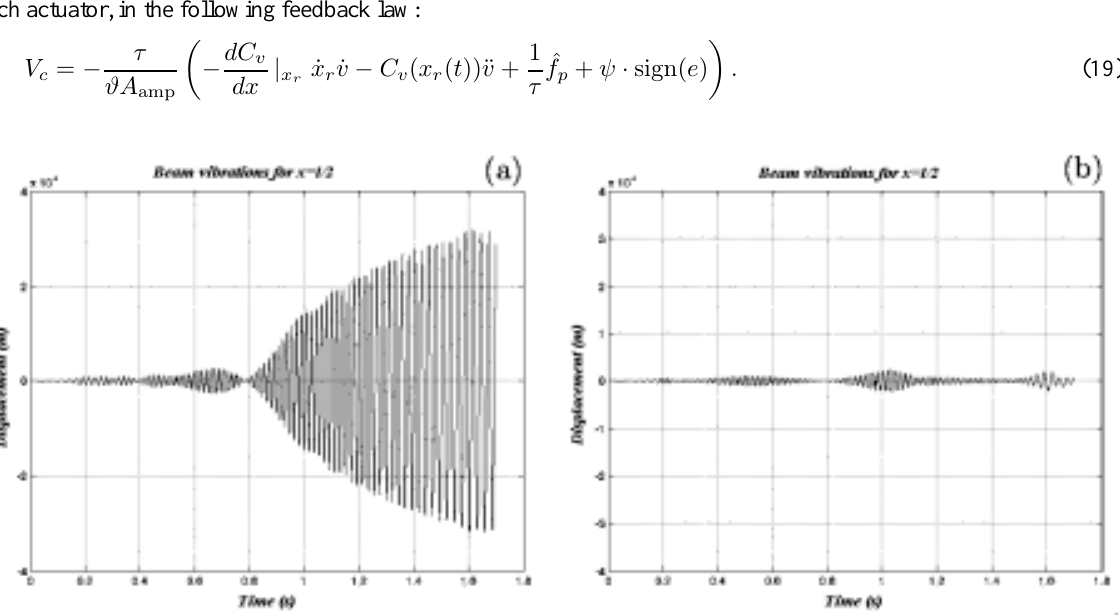
Fig. 3. Beam half-point vibrations: a) open loop, b) closed loop.